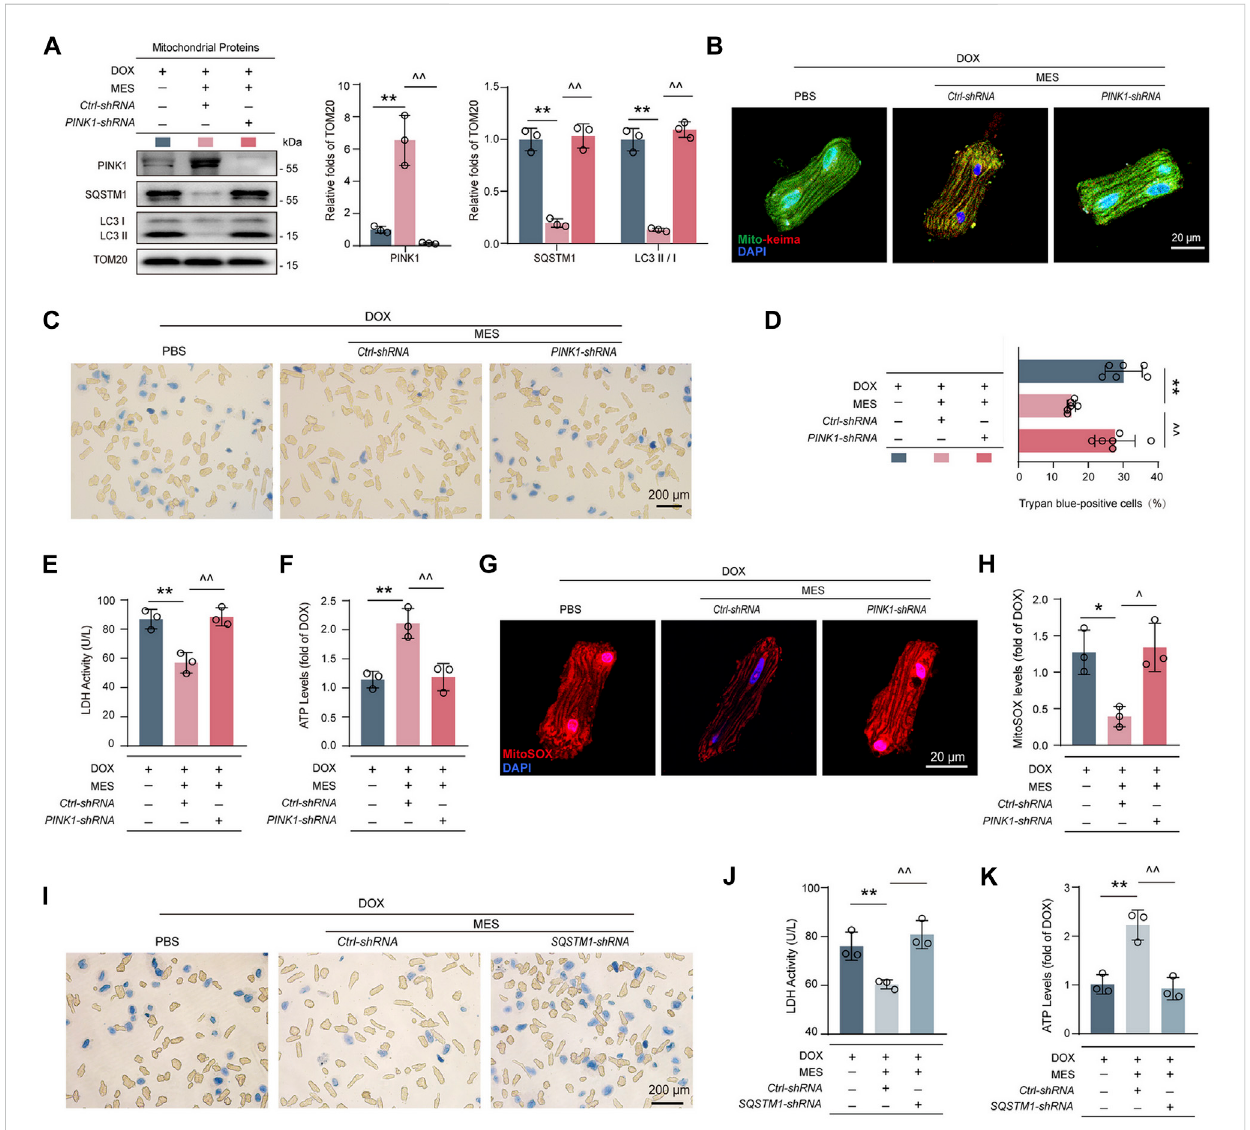
FIGURE 5 PINK1 or SQSTM1 de fi ciency restricted the cardioprotective effects of mesaconine by inhibiting mitophagy. (A) Immunoblotting analysis for the expressions of PINK1, SQSTM1 and LC3II/I in mitochondria isolated primary cardiomyocytes. Representative immunoblots and the ratio of the indicated protein to TOM20 are presented. (B) Cardiomyocytes expressing Mito-Keima were used to visualize mitophagy following the treatment of DOX or/and mesaconine under a confocal microscope. (C) Representative trypan blue staining images of primary cardiomyocytes. Quantitative analysis of (D) trypan blue staining positive cardiomyocytes, (E) LDH release, and (F) ATP contents of primary cardiomyocytes. (G) Representative images of mitochondrial ROS are indicated by MitoSOX red which can be oxidized by superoxide in mitochondria and then produce red fl uorescence. (H) Quanti fi cationofMitoSOXlevels. (I – K) Trypanbluestaining images (I) LDHrelease (J) andATPcontents (K) ofprimary cardiomyocyteswereassayed and showed that depletion of SQSTM1 reversed the cardioprotective effects of mesaconine. Data are represented as means ± SEM of at least 3